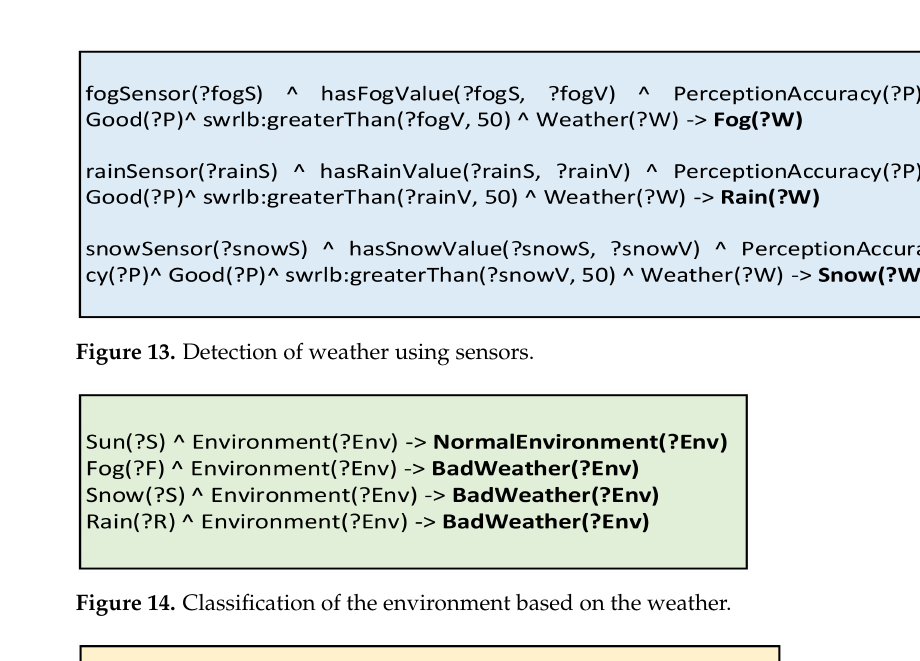
Figure 15. Detection of brightness using sensors.